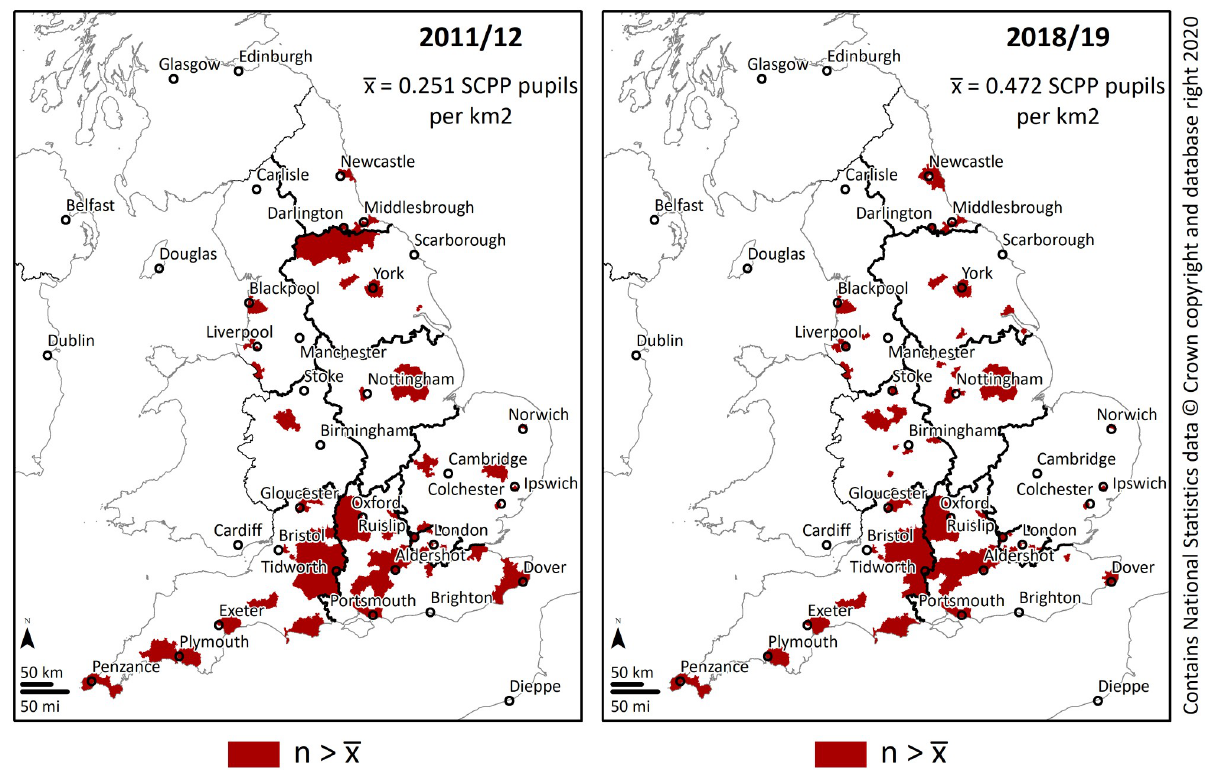
Fig 2. Constituencies with a density of SCPP pupils above England’s